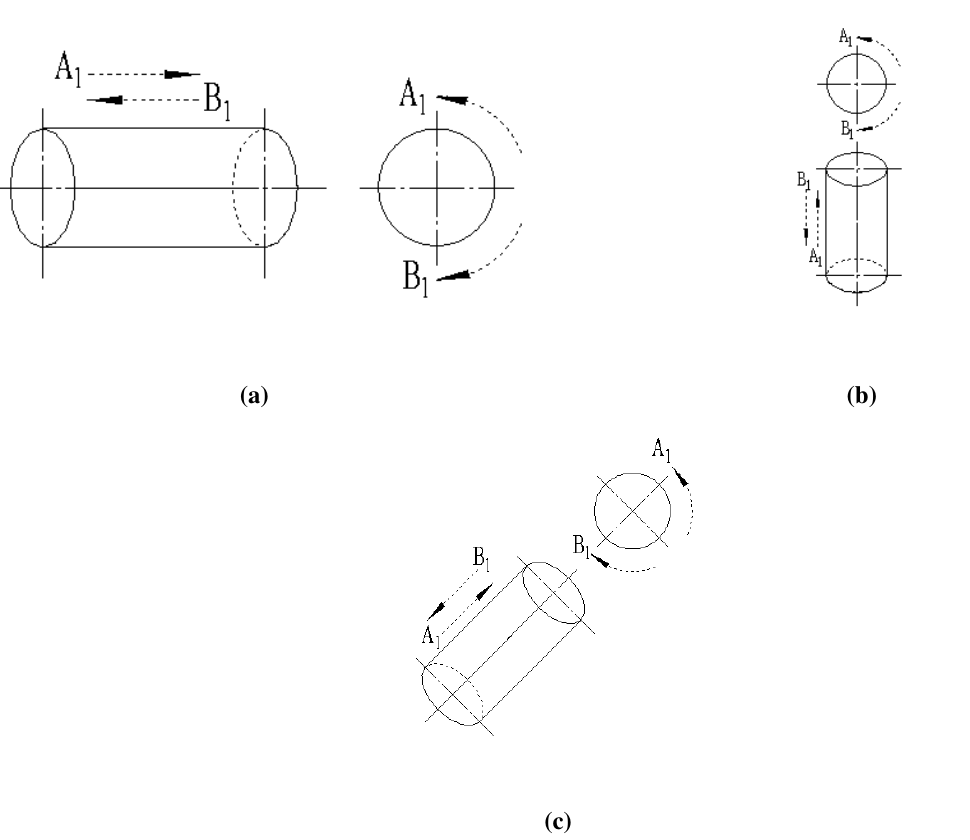
Fig. 10 Motion planning for the straight